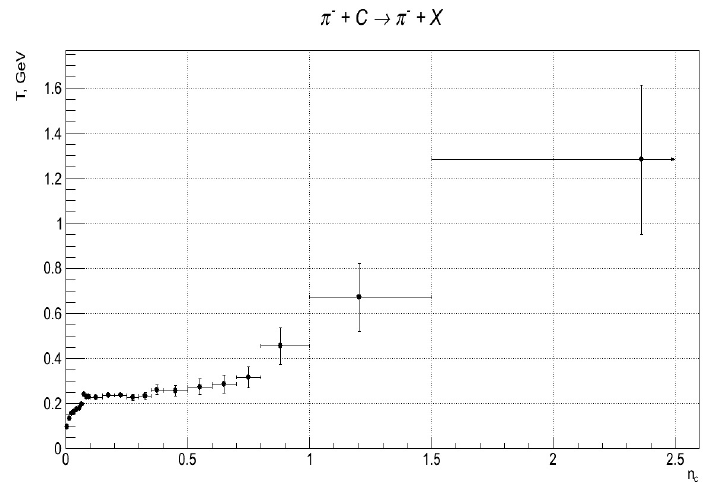
Figure 2. E ff ective temperature T vs cumulative number n c for π − mesons